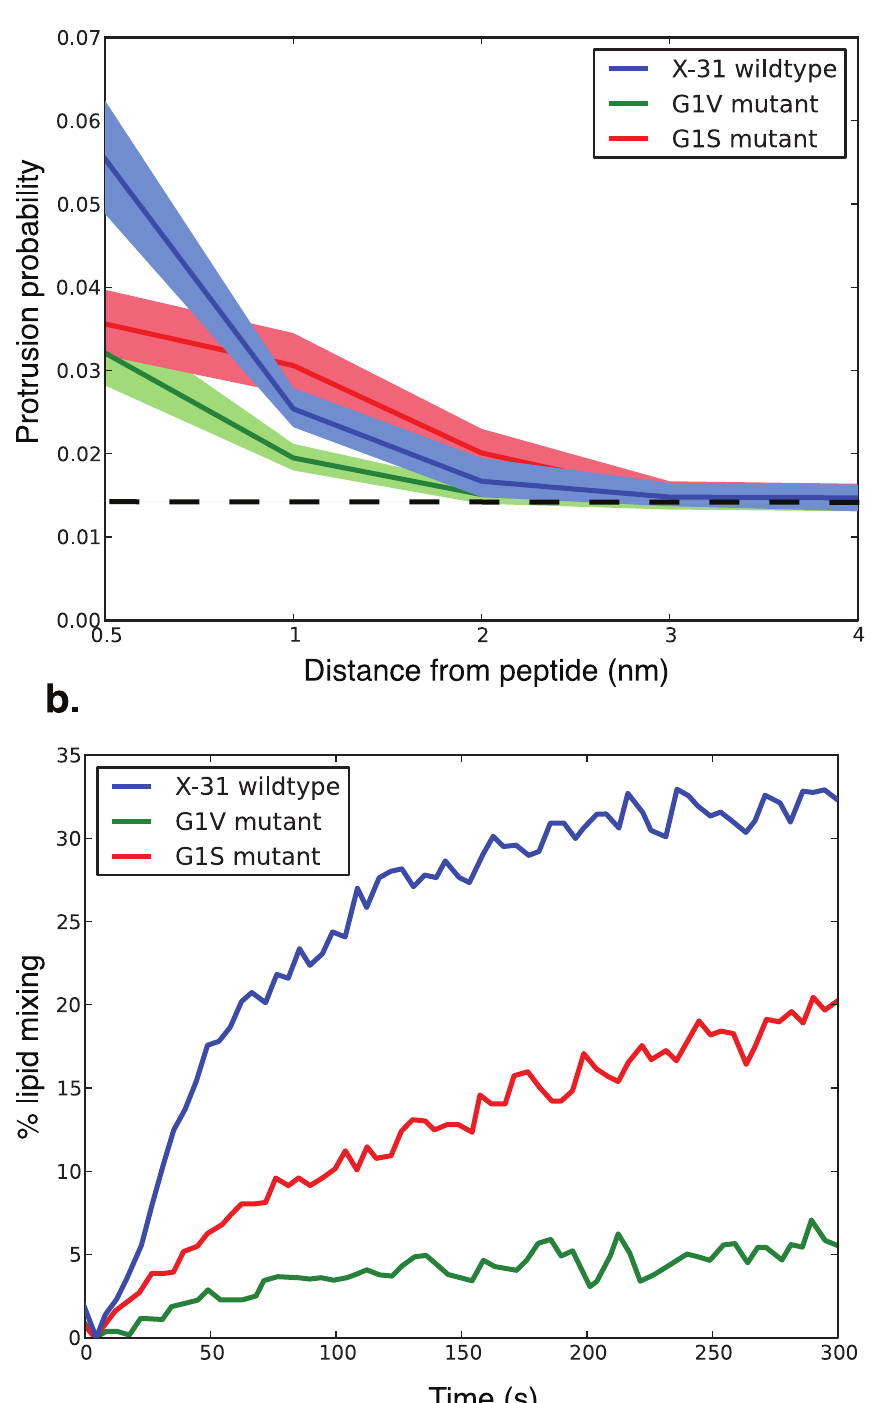
Figure 2. Lipid tail protrusion is increased close to fusion-active peptides. Protrusion probability is plotted in (a) as a function of distance from the nearest peptide for the full set of 600 trajectories, and compared with fusion kinetics (b) measured via lipid mixing for transfectants expressing each mutation replotted from Qiao et al. [2]. The protrusion probability is greatest for fusion peptides with an N-terminal glycine (X-31 wild-type). Protrusion is approximately half as likely near G1V mutant peptides (p , 0.01, Kolmogorov-Smirnov test). The G1S peptide shows an intermediate behavior. Shaded areas denote 95% confidence intervals calculated using bootstrap resampling.